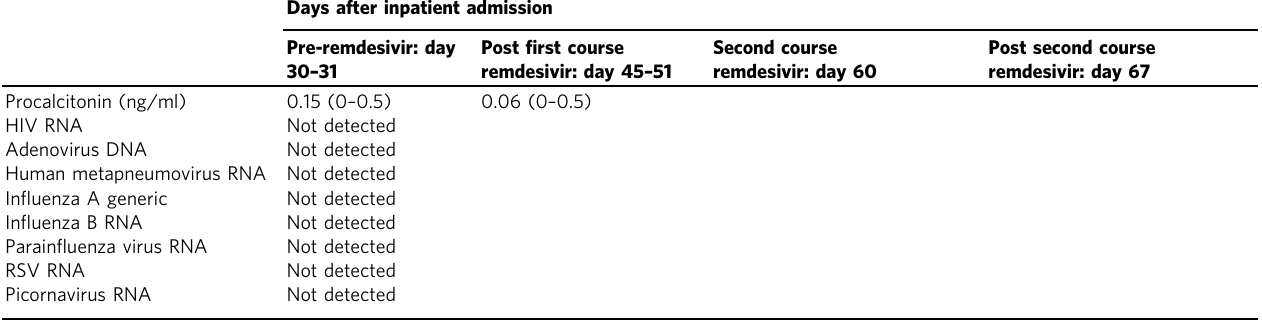
Numbers in parentheses indicate reference values of the corresponding